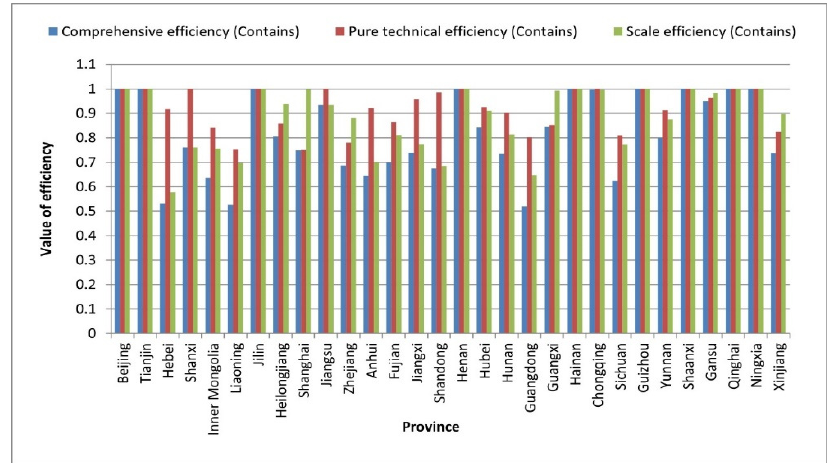
Figure 4. Efficiency values of consumption based intensity index.